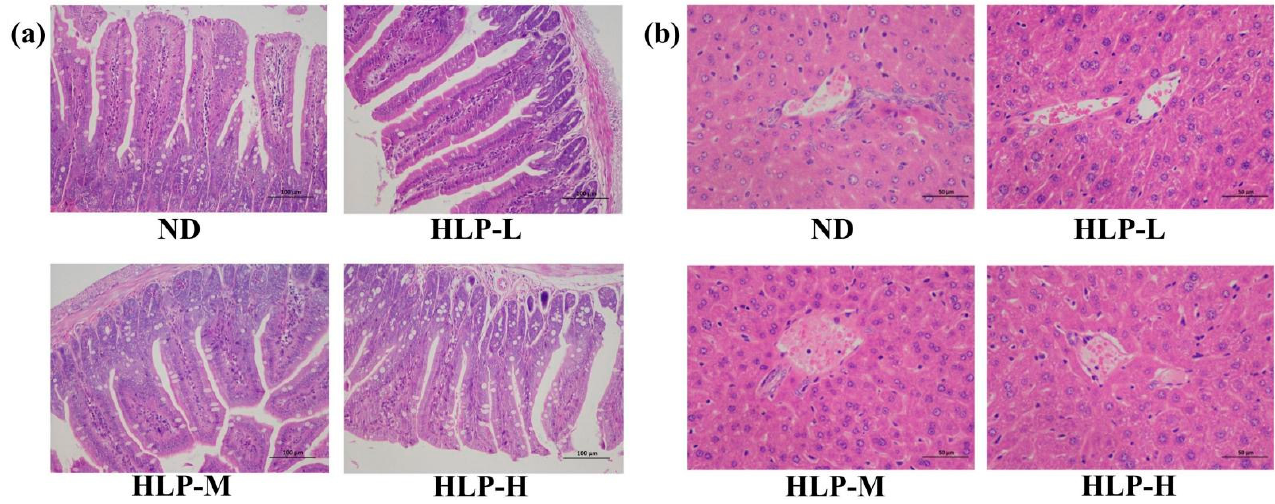
Figure 3. Histological examination of the ileum ( a ) and liver ( b ) by H&E staining (200×).